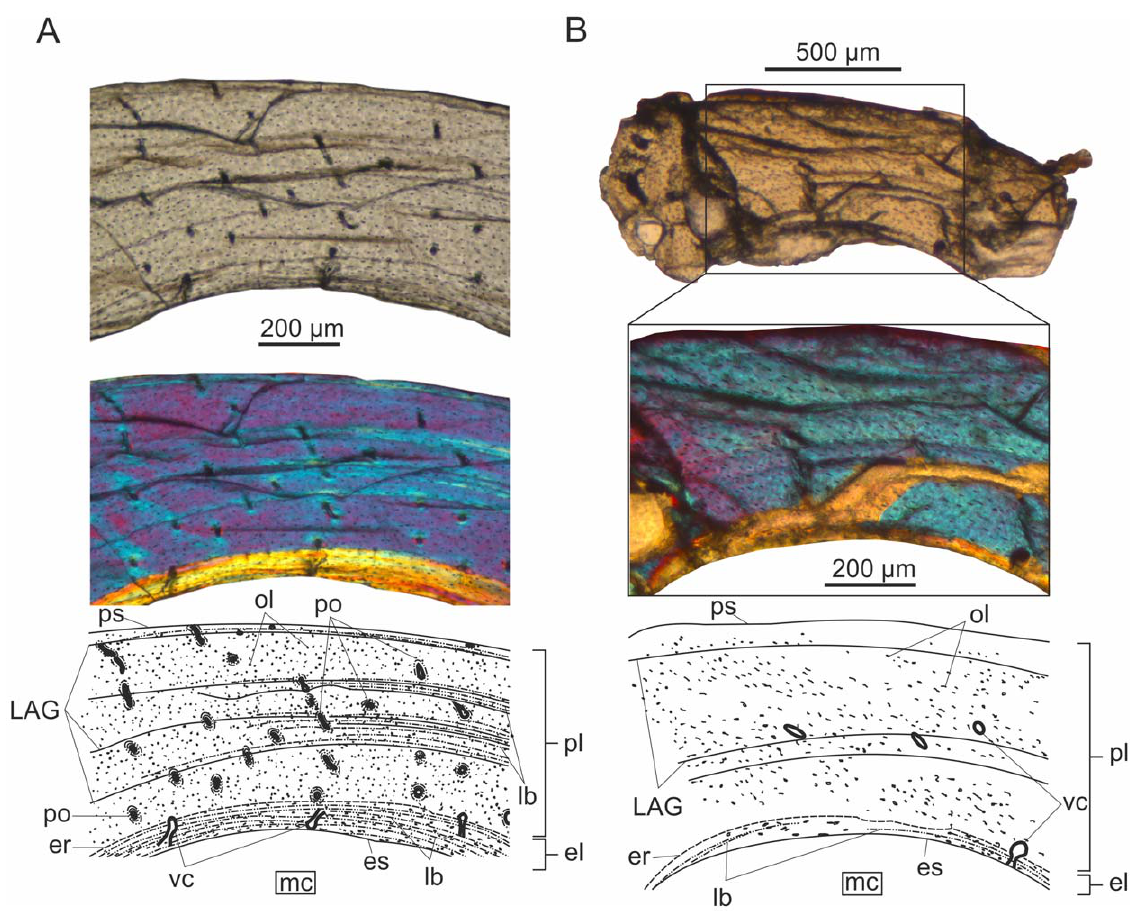
Figure 6. Histological sections of long bones of BSPG 1929 I 69 viewed with polarized microscopy. (A) The femoral cortex has a very thick layer of endosteal lamellae. The parallel-fibred periosteal bone is moderately well vascularized by mostly longitudinal channels. Deep intracortical LAGs within three to four thin, lamellar-fibred annuli are present. (B) The medullar cavity of the tibia is lined by endosteal bone. The bulk of its cortex is composed of an almost avascular, parallel-fibred primary bone tissue with a few, widely spaced LAGs.